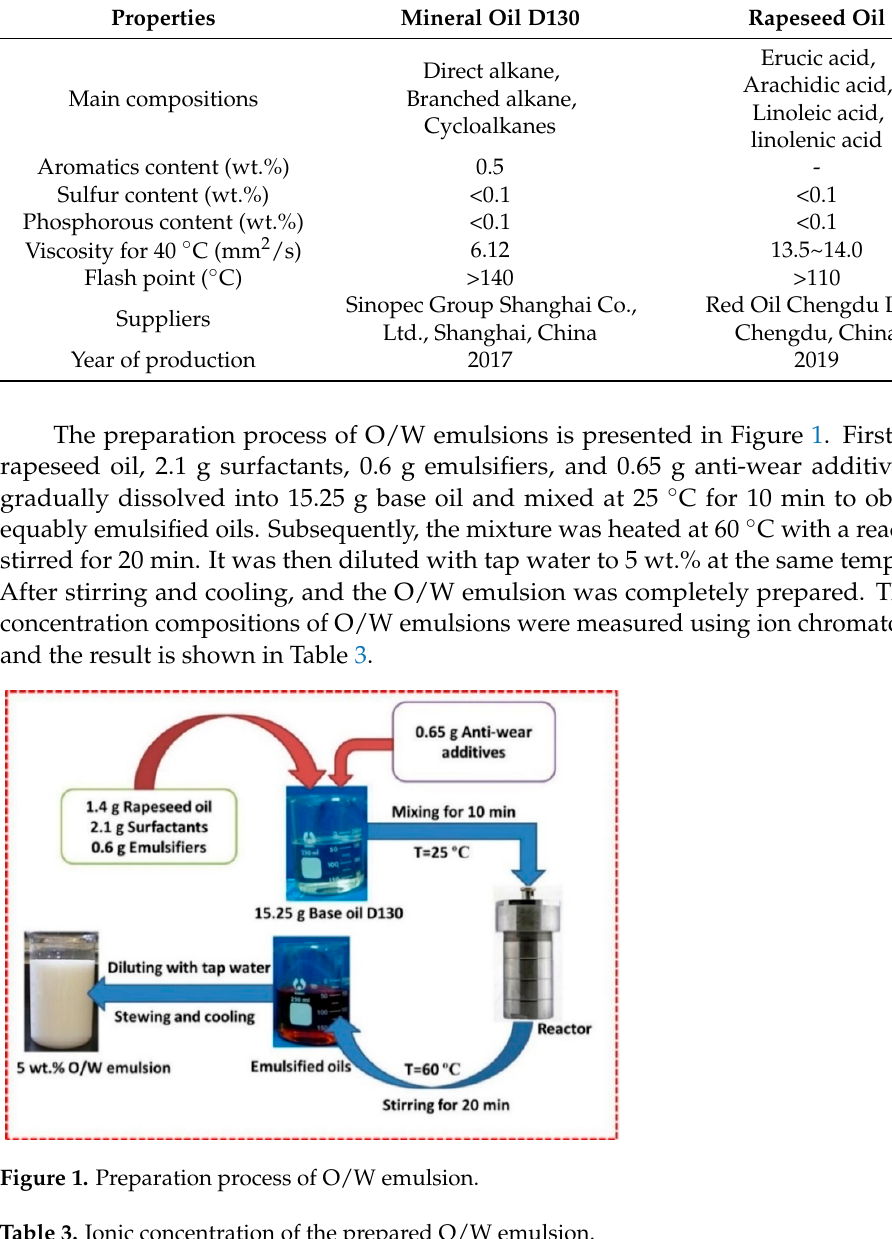
Table 2. Details on composition and physiochemical properties of mineral oil D130 and rapeseed oil.